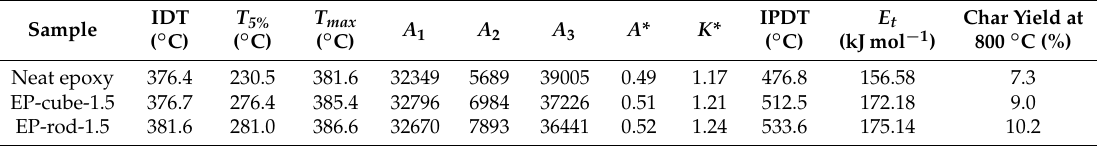
Table 1. Thermal stability factors of neat epoxy, EP-cube-1.5 and EP-rod-1.5 obtained from TGA thermograms. Sample